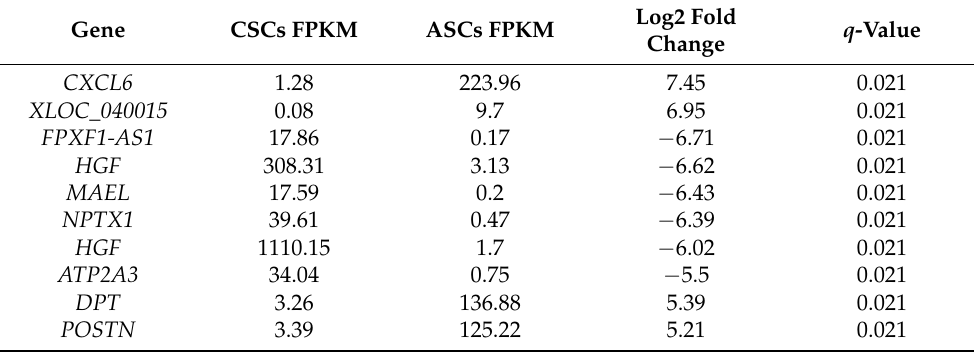
Table 2. Top 10 most significantly differentially expressed